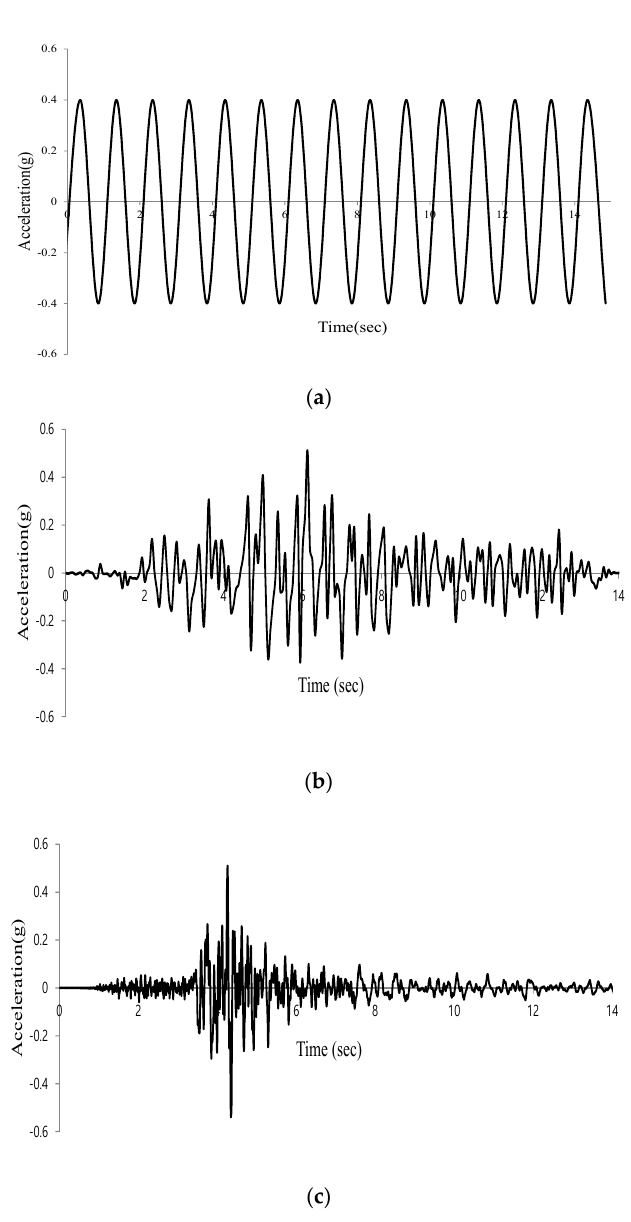
Figure 5. Acceleration–time history of input motion: ( a ) Acceleration-time history of base input for sine wave (1 Hz, 0.4 g); ( b ) Acceleration-time history of base input for Ofunato earthquake (a max = 0.51 g); ( c ) Acceleration-time history of base input for Nisqually earthquake (a max = 0.51 g).